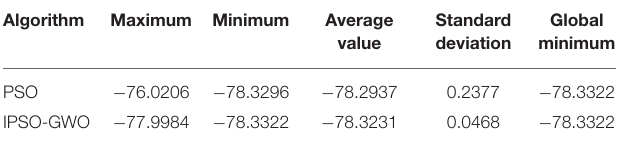
TABLE 9 | Styblinski-Tang function test results.